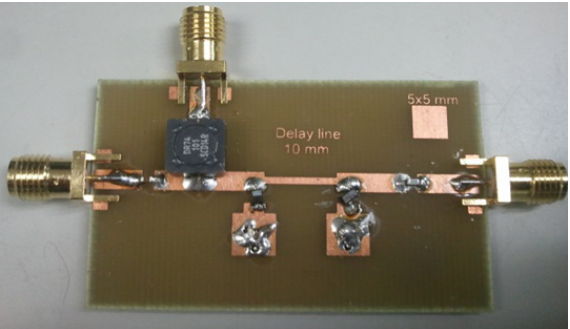
Figure 4: SRD pulse sharping circuit.